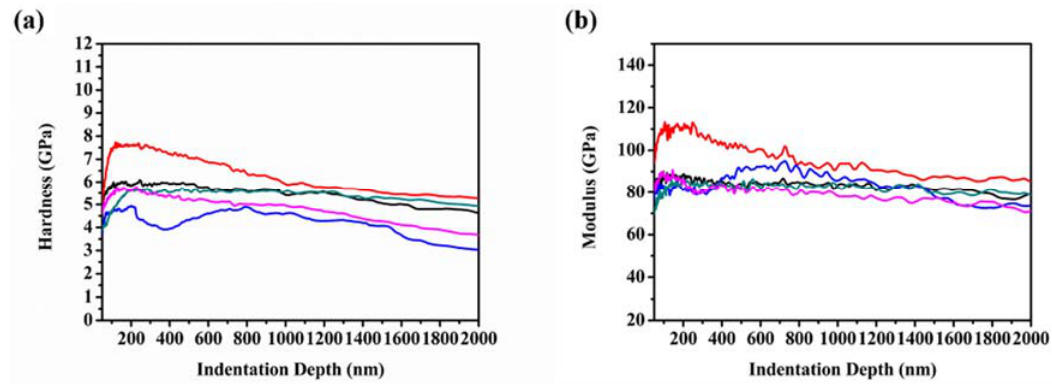
Figure 4. ( a ) hardness ‐ depth curves of (002) oriented coatings at different positions, and ( b ) elastic modulus ‐ depth curves of (002) oriented coatings at different positions. In this figure, the different colors represent different positions. Hardness and elastic modulus were measured at different positions of HA coatings to get average value.